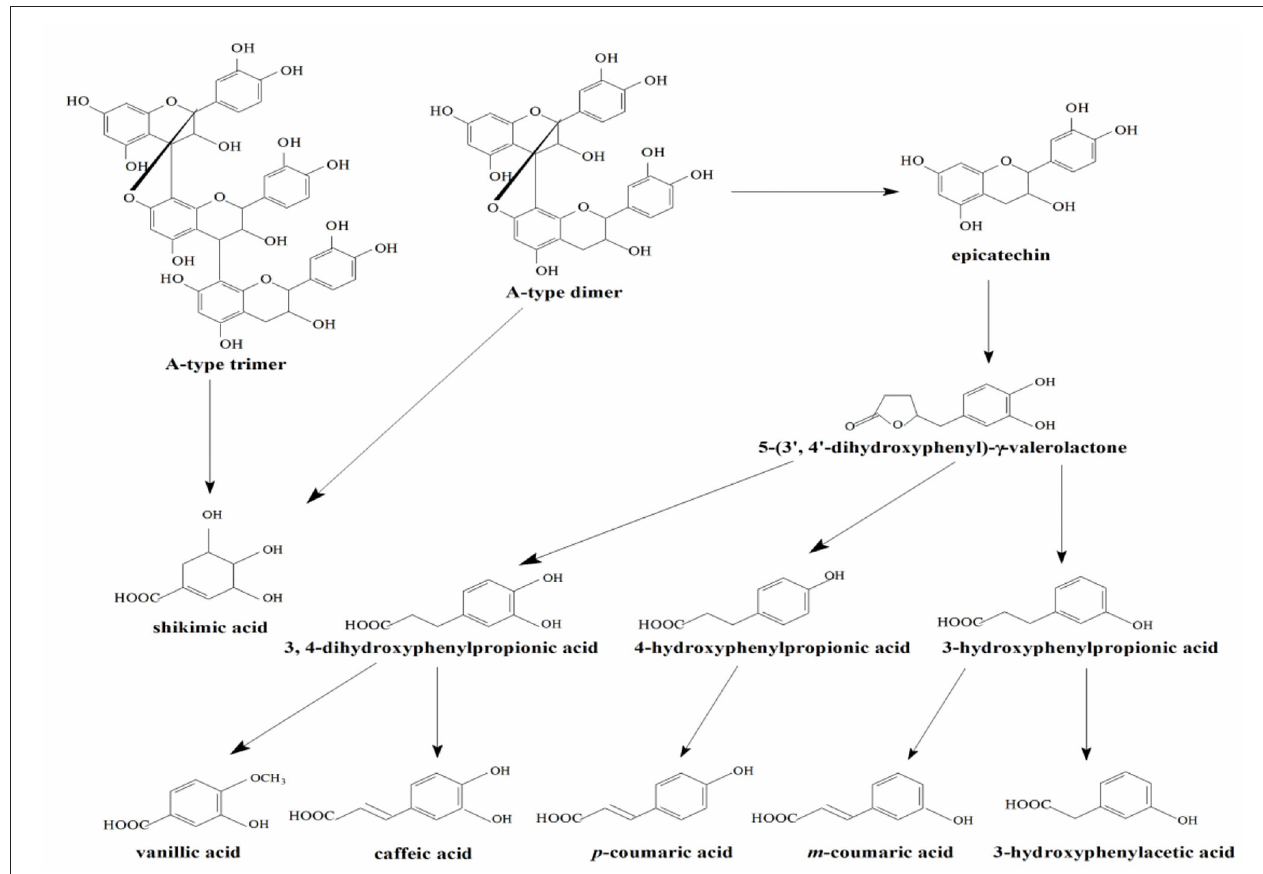
FIGURE 2 | Proposed metabolic pathway of LPPC by the intestinal microflora.